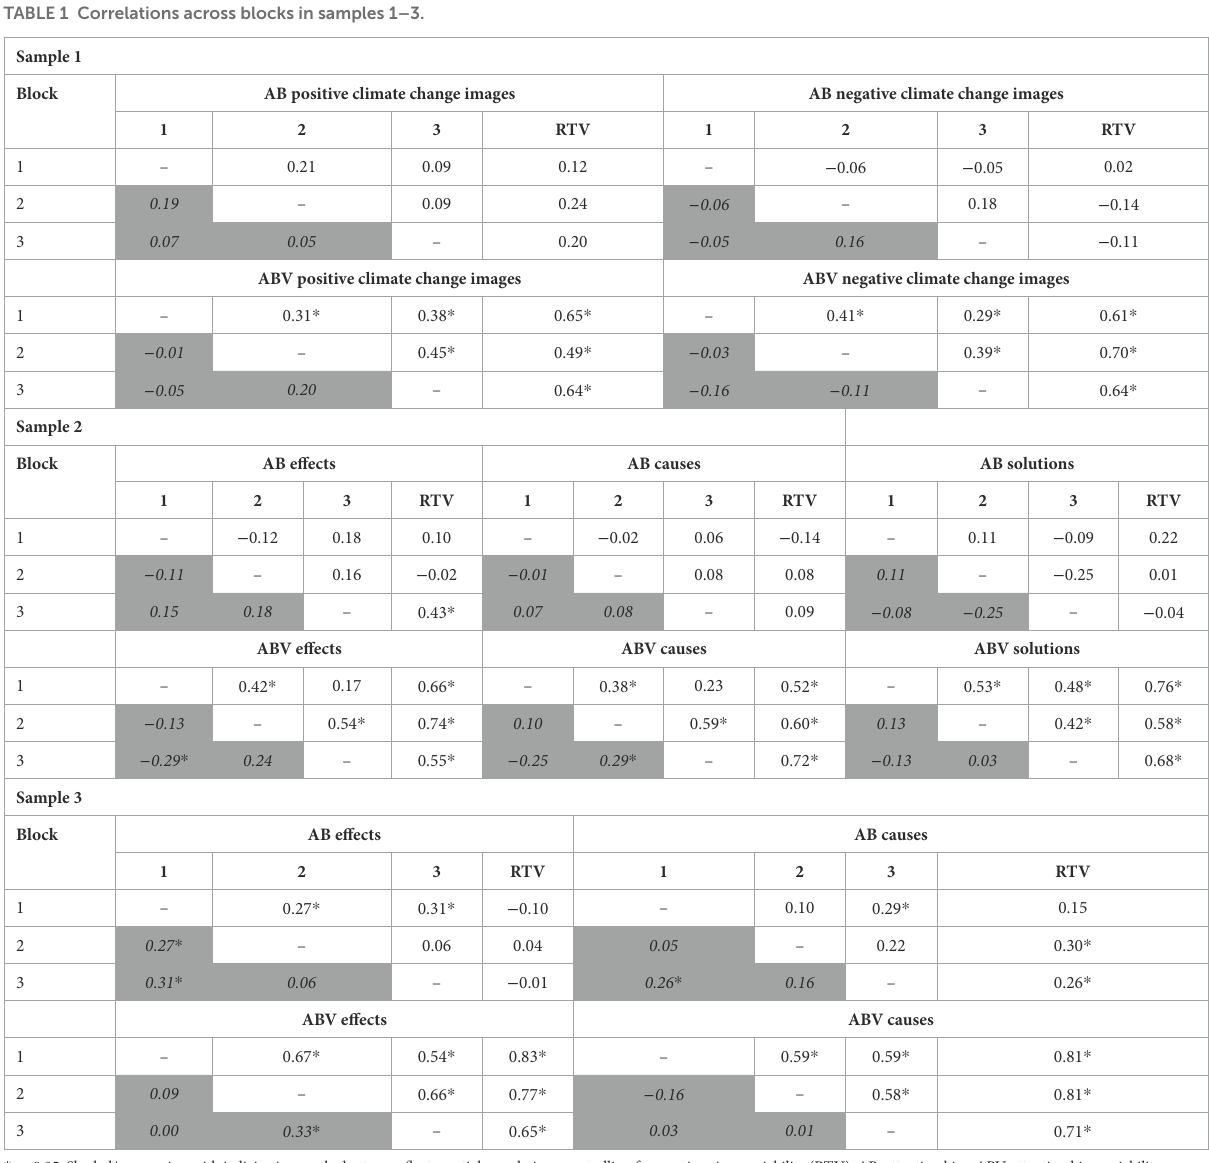
TABLE 1 Correlations across blocks in samples